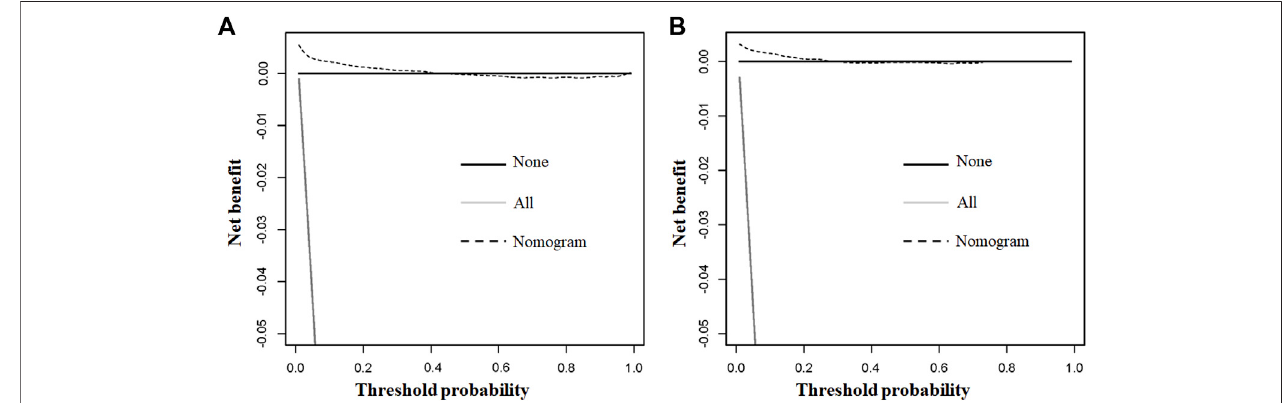
FIGURE5| Thetrainingandthevalidationsets ’ decisioncurveanalysis(DCA)ofthenomograminourstudyforpredictingbonemetastasisinheadandneckcancer patients. Black line denotes none; grey line all; dotted line nomogram.